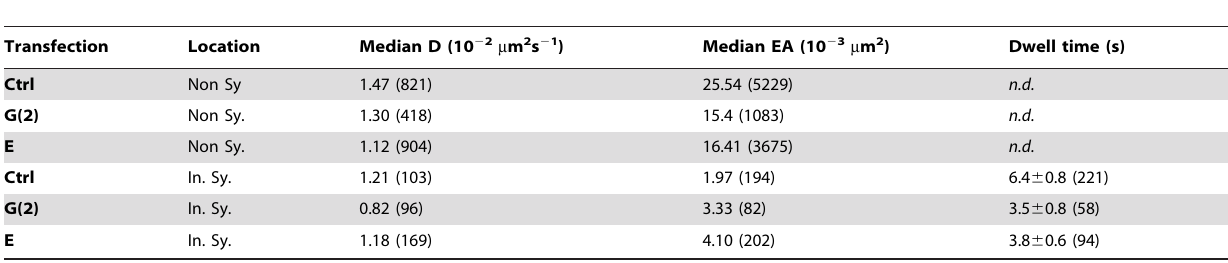
Table 2. Effects of gephyrin dominant negative chimera on the diffusion properties of the GABAAR c 2 subunit.